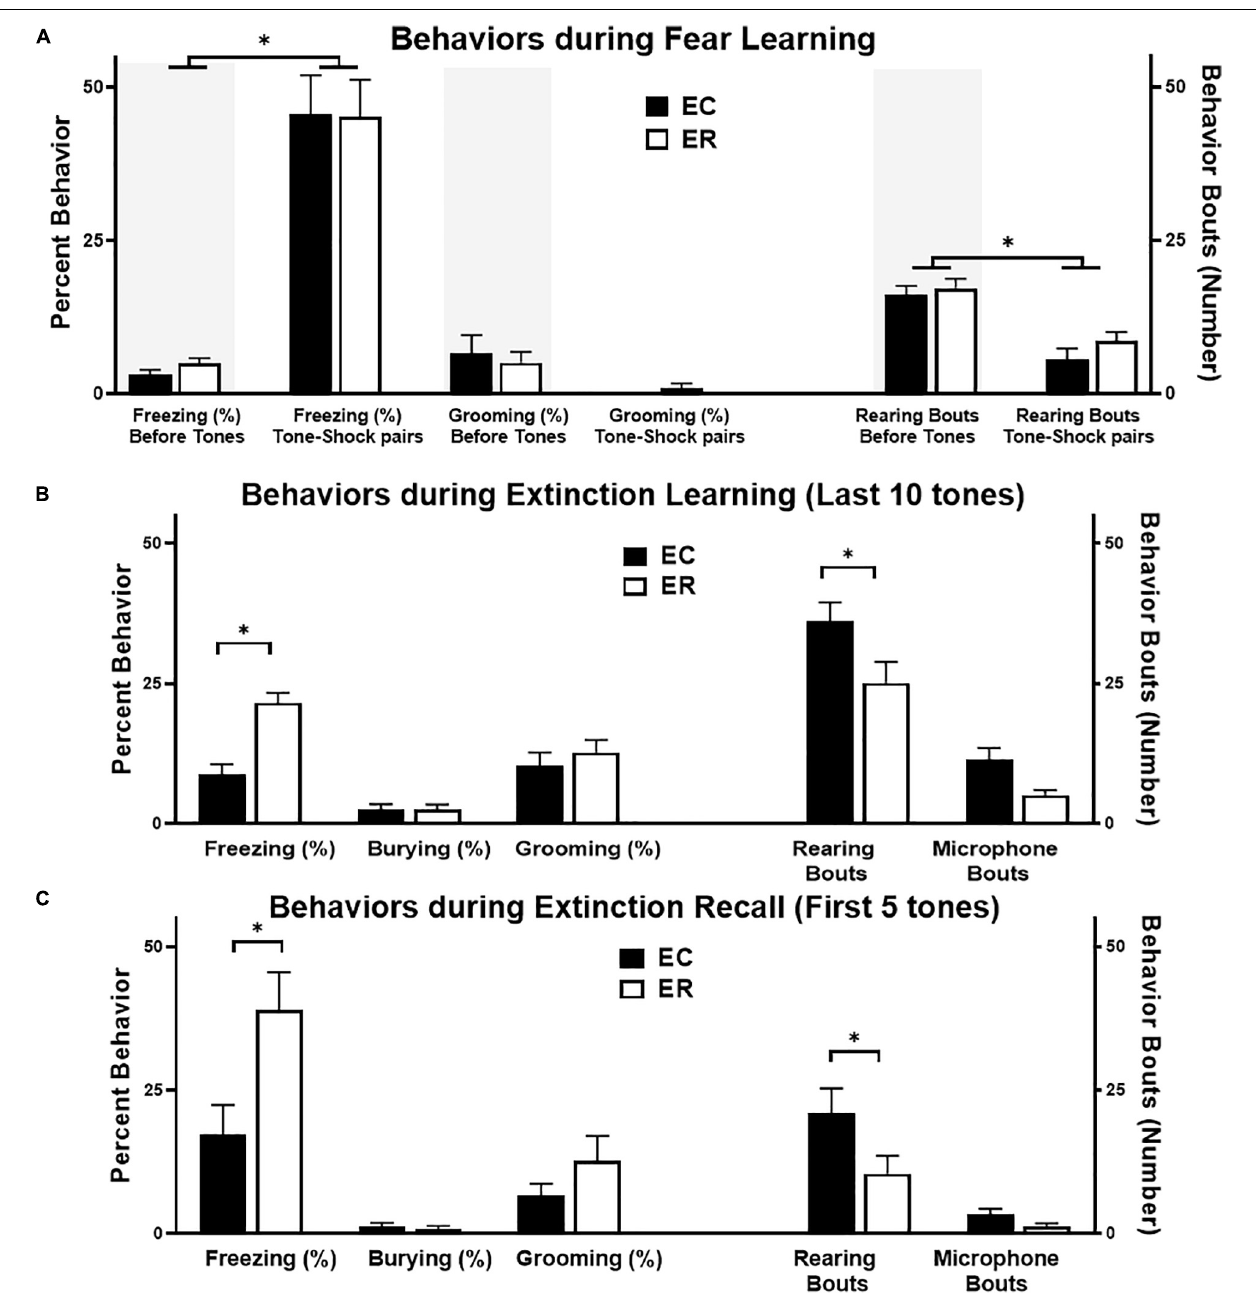
FIGURE 2 | Summary of behaviors in extinction competent (EC; black bars) and extinction resistant (ER, open bars) female rats during fear learning (A) , the last 10 tones during extinction learning (B) , and the first 5 tones of extinction recall (C) . The left Y axis is for the percent of time spent freezing, grooming, or burying, while the right Y axis is for the number of rearing bouts or microphone interactions. Percent freezing is from automated analysis with FreezeScan, while other behaviors were hand-scored using Observer R (cid:13) XT. During fear learning (A) , both the 3 min prior to conditioning (shaded areas) and the 3 min during tone–shock pairings are shown. Both ER and EC rats display similar increases in freezing alongside a decrease in rearing during the tone–shock pairings phase of fear learning. During both extinction learning (B) and extinction recall (C) ER females froze significantly more than EC rats, and ER rats displayed fewer rears than EC females during this same period. Bars represent mean ± SEM, with N = 7 ER and N = 7 EC rats per group. ∗ P <